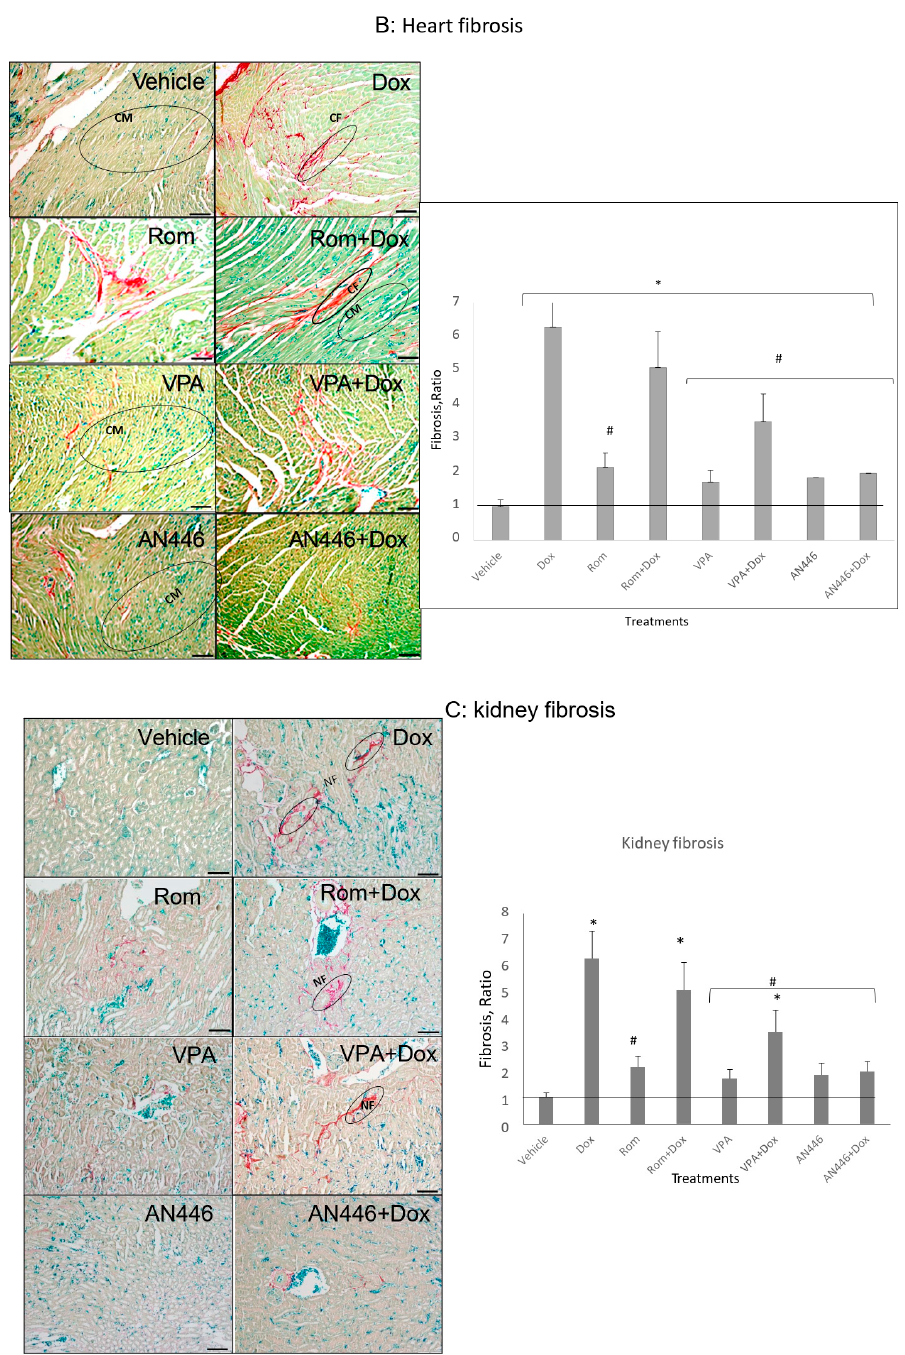
Figure 3. Effect of HDACIs, Dox and their combinations on fibrosis in tumors ( A ), hearts ( B ), and kidneys ( C ). Sections of organs were stained with Picrosirius red and fast green for fibrous collagen for the visualization of interstitial fibrosis. Bar = 200 µ m, the 4-fold magnified picture with 10-fold magnified in the inserts, taken from the area indicated by the square. Quantifying fibrosis was performed on four different fields/sections taken from three mice/groups. tumors ( A ), hearts, CM = cardiomyocytes; CF = cardio-fibrosis ( B ), kidneys, NF = nephron-fibrosis ( C ). Statistical analyses were performed with graph prism 7.3. Outliners were identified using * p < 0.05 for all drugs treated vs. vehicle-treated mice; # p < 0.05 drug-treated vs. Dox-treated; ∆ p < 0.05, drug-treated vs. Rom + Dox-treated